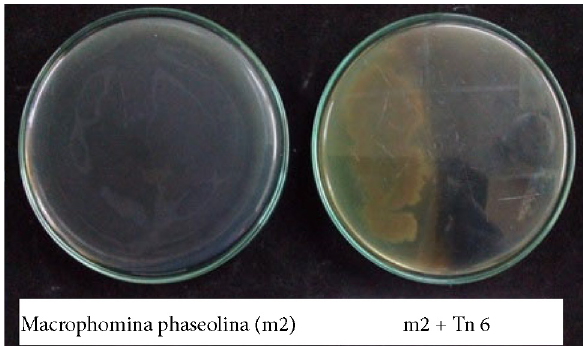
Figure 1. In vitro inhibition of pathogen m2 by Pseudomonas aeruginosa (Tn